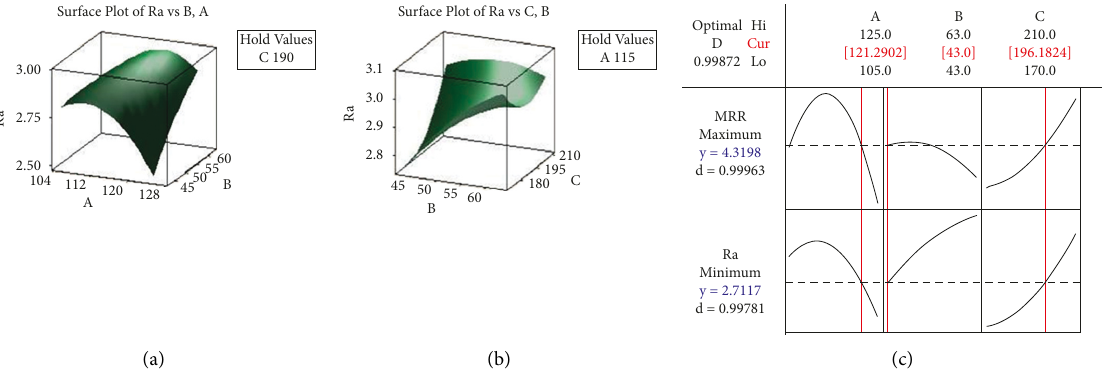
Figure 8: (a) Surface plot of Ra vs (C) A., (b) surface plot of Ra vs (C) B., and (c) optimization plot of MRR,